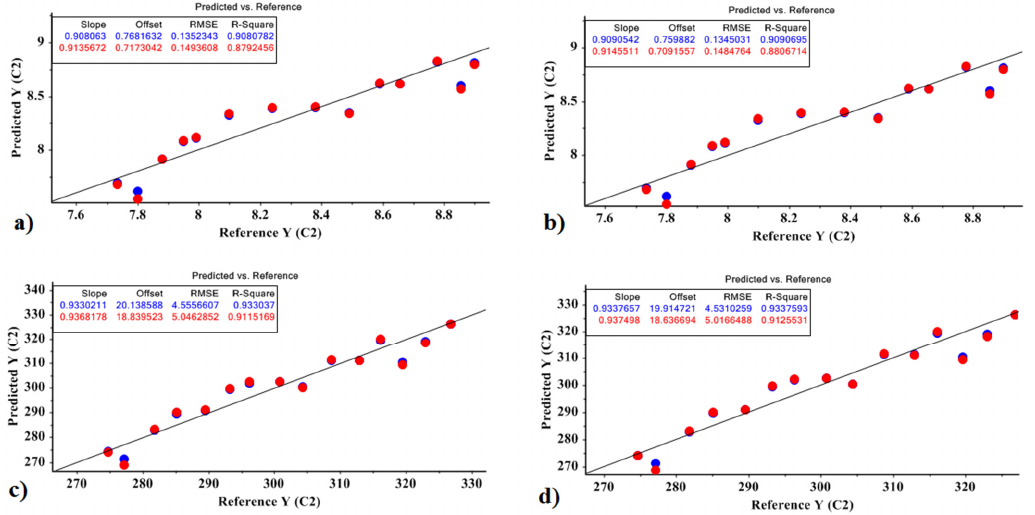
Figure 7. MLR prediction models for predicting the amount of carbohydrate and sugar in the Marfona cultivar: ( a ) the amount of sugar based on the PCR method; ( b ) the amount of sugar based on the PLSR method; ( c ) the amount of carbohydrate based on the PCR method; ( d ) the amount of carbohydrate based on the PLSR method. Sugar based on PCR = 8.355 − 30.676 + 0.022 The values obtained for the model were R 2 = 0.879 and RMSE = 0.149; p < 10 − 4 .